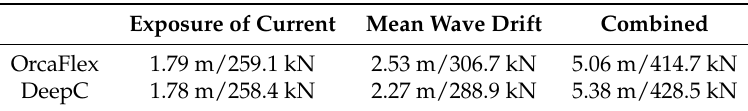
Table 10. Comparison of surge motion and line tension obtained by OrcaFlex and DeepC. The table compares exposure to current and mean wave drift separately and